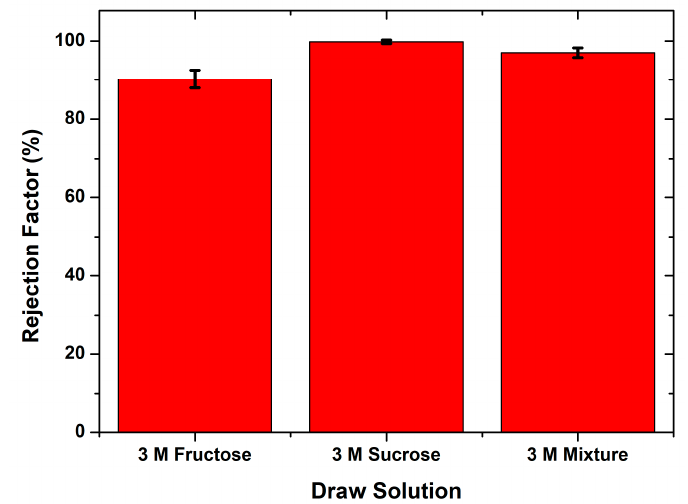
Figure 5. The rejection factor percentage of ion particles in the FO process from brackish water with di ff erent draw solutions.